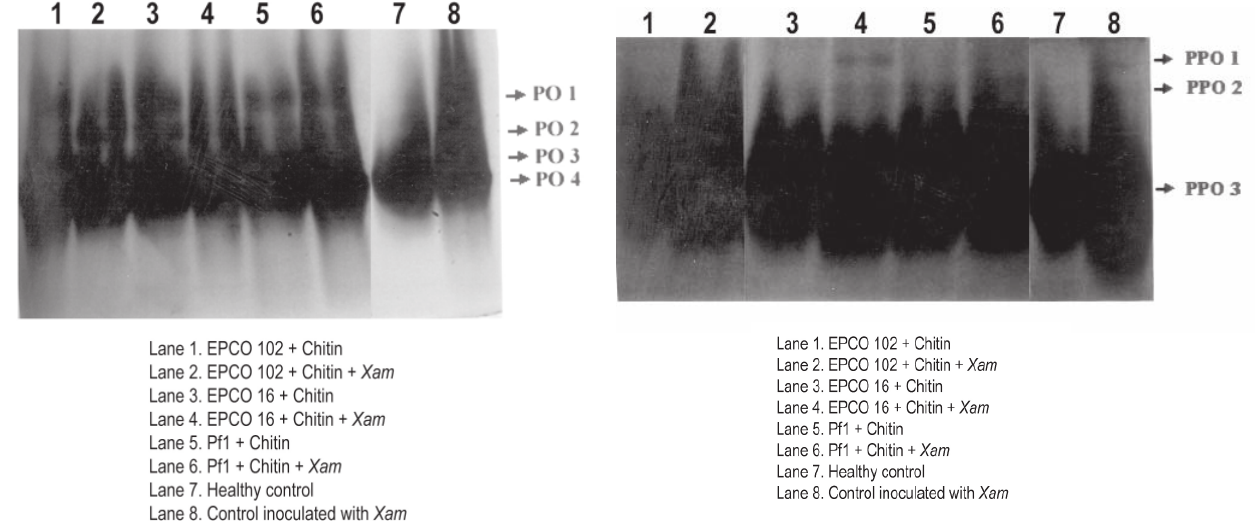
Fig. 3. Native PAGE of polyphenol oxidase in cotton plants treated with endophytic bacterial strains against Xanthomonas axonopodis pv. malvacearum (Xam).